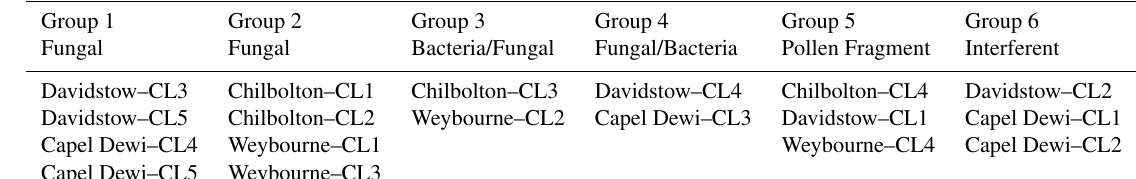
Table 3. Summary table of similar clusters (CL) between sites with the inferred cluster grouping and type.